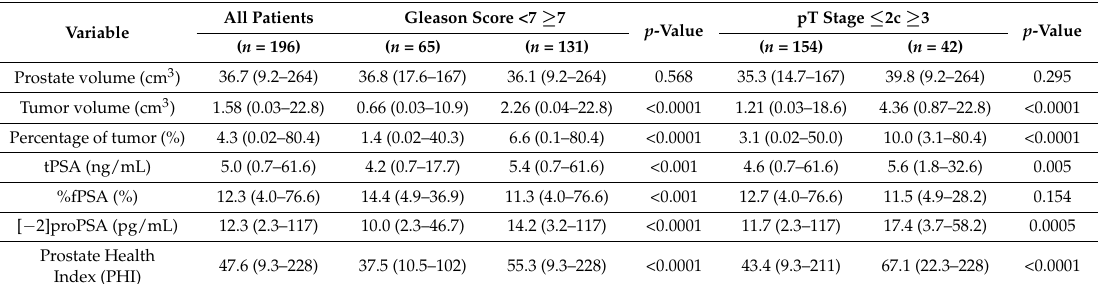
Table 2. Prostate volume, tumor volume, and prostate-specific antigen (PSA) analytes (median and range) in dependence on Gleason score and pathological tumor stage.